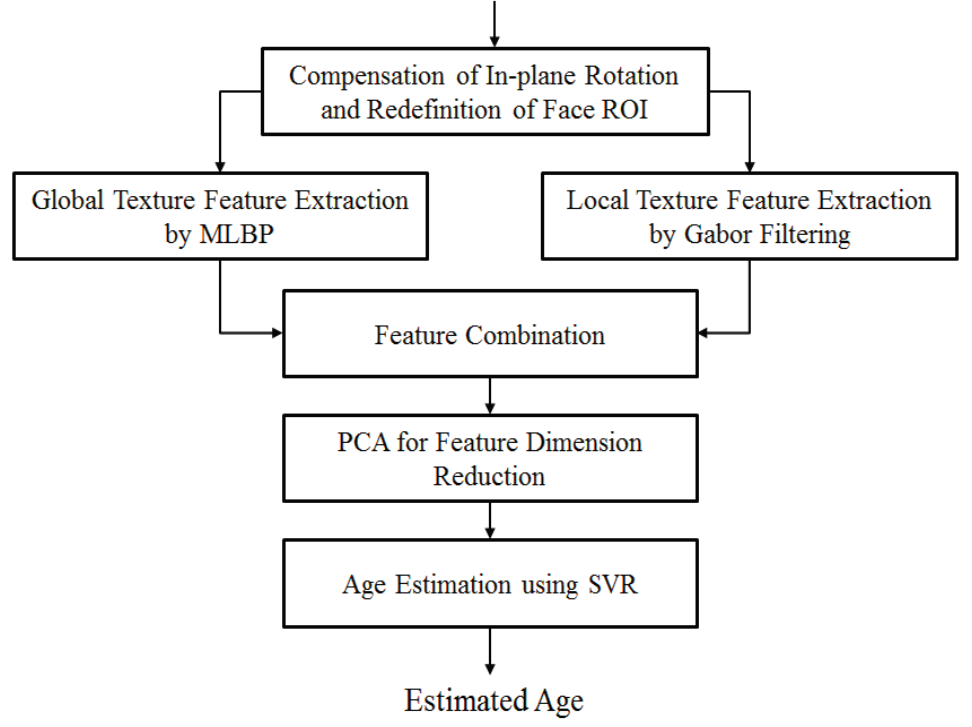
Figure 13. Procedure for age estimation method based on MLBP, Gabor filtering, PCA and